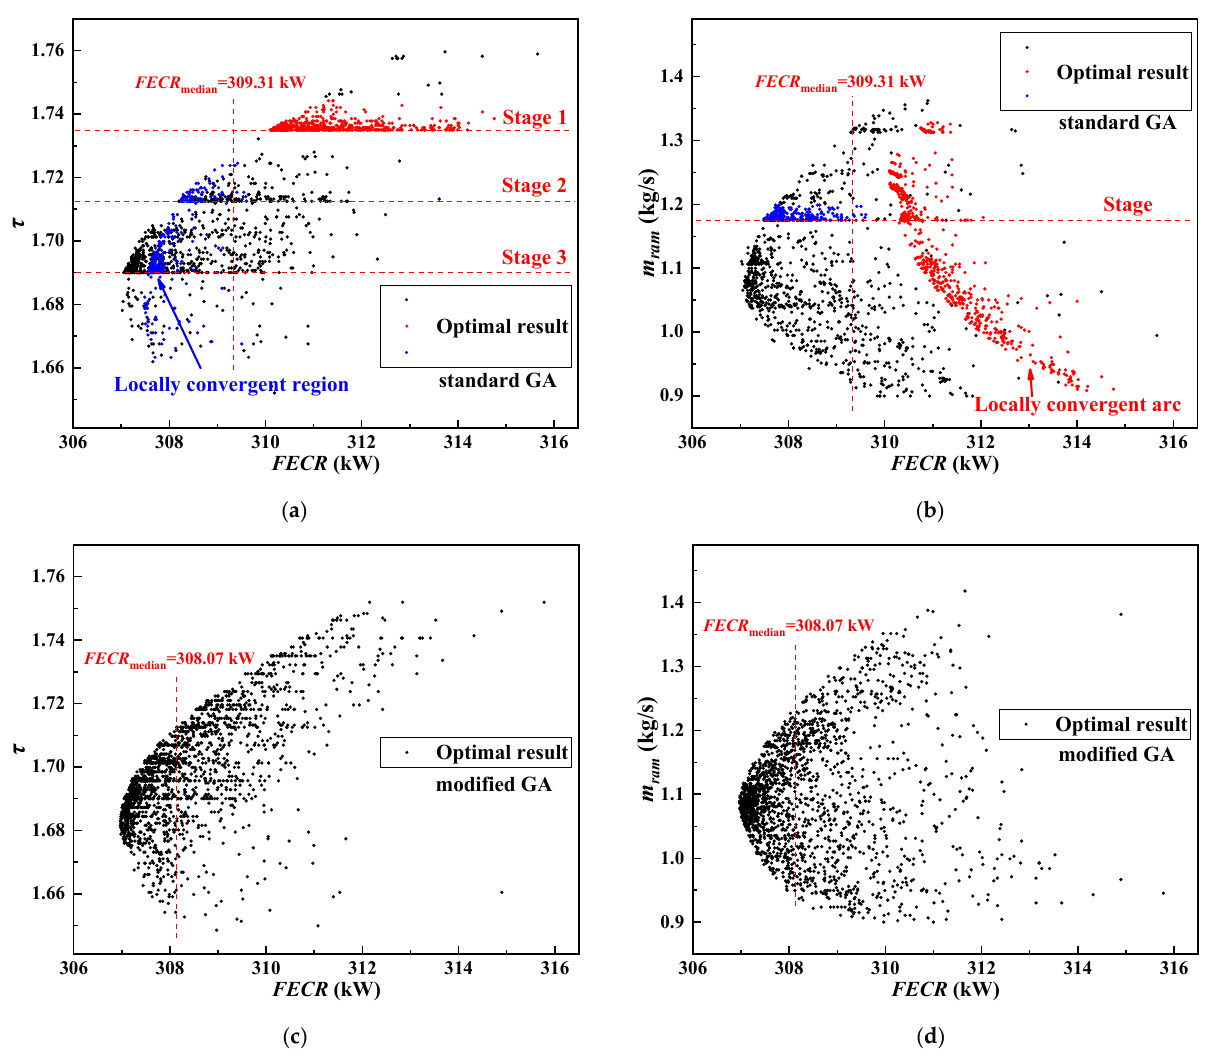
Figure 4. Distributions of design variables with the corresponding optimal FECR. ( a ) 2000 optimal results over 3000 iterations of standard GA, τ -FECR ; ( b ) 2000 optimal results over 3000 iterations of standard GA, m ram - FECR ; ( c ) 2000 optimal results over 3000 iterations of modified GA, τ -FECR ; ( d ) 2000 optimal results over 3000 iterations of modified GA, m ram - FECR .